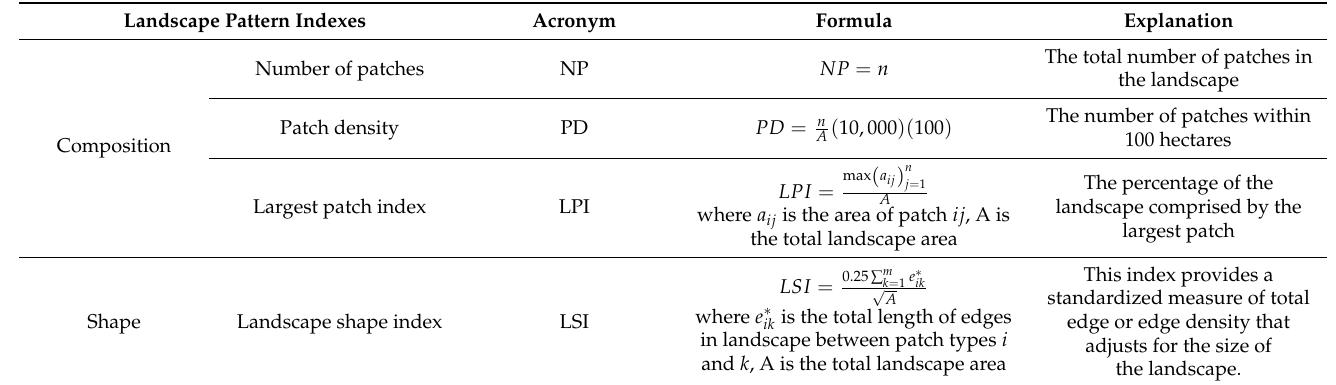
Table A1. Formulas and explanations of landscape-pattern indexes